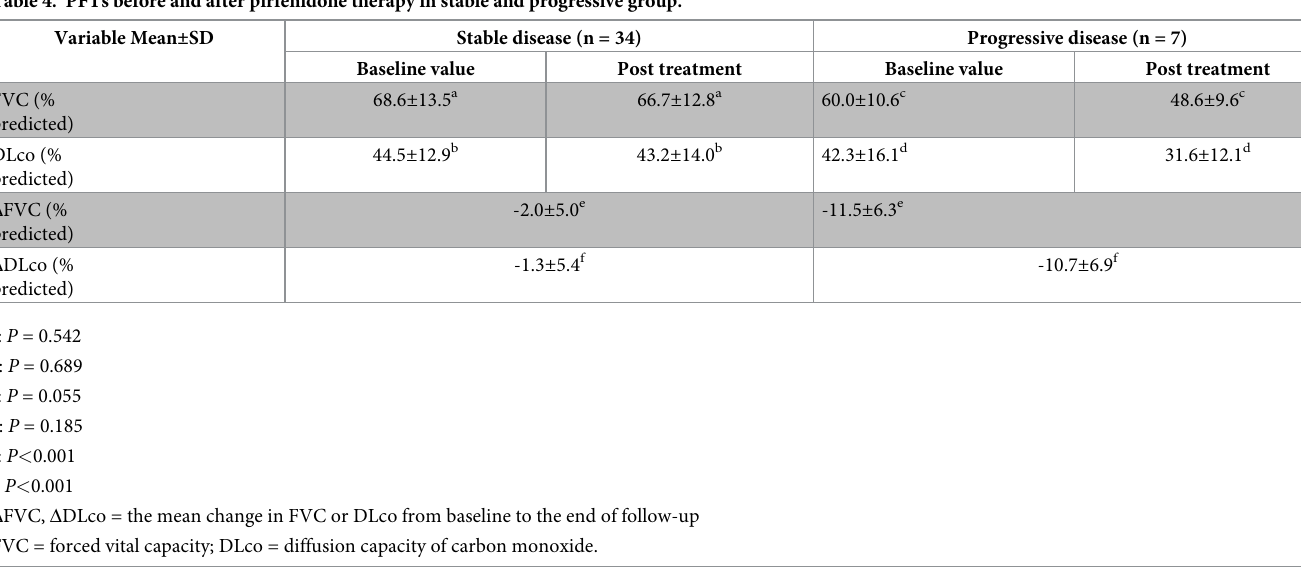
Table 4. PFTs before and after pirfenidone therapy in stable and progressive